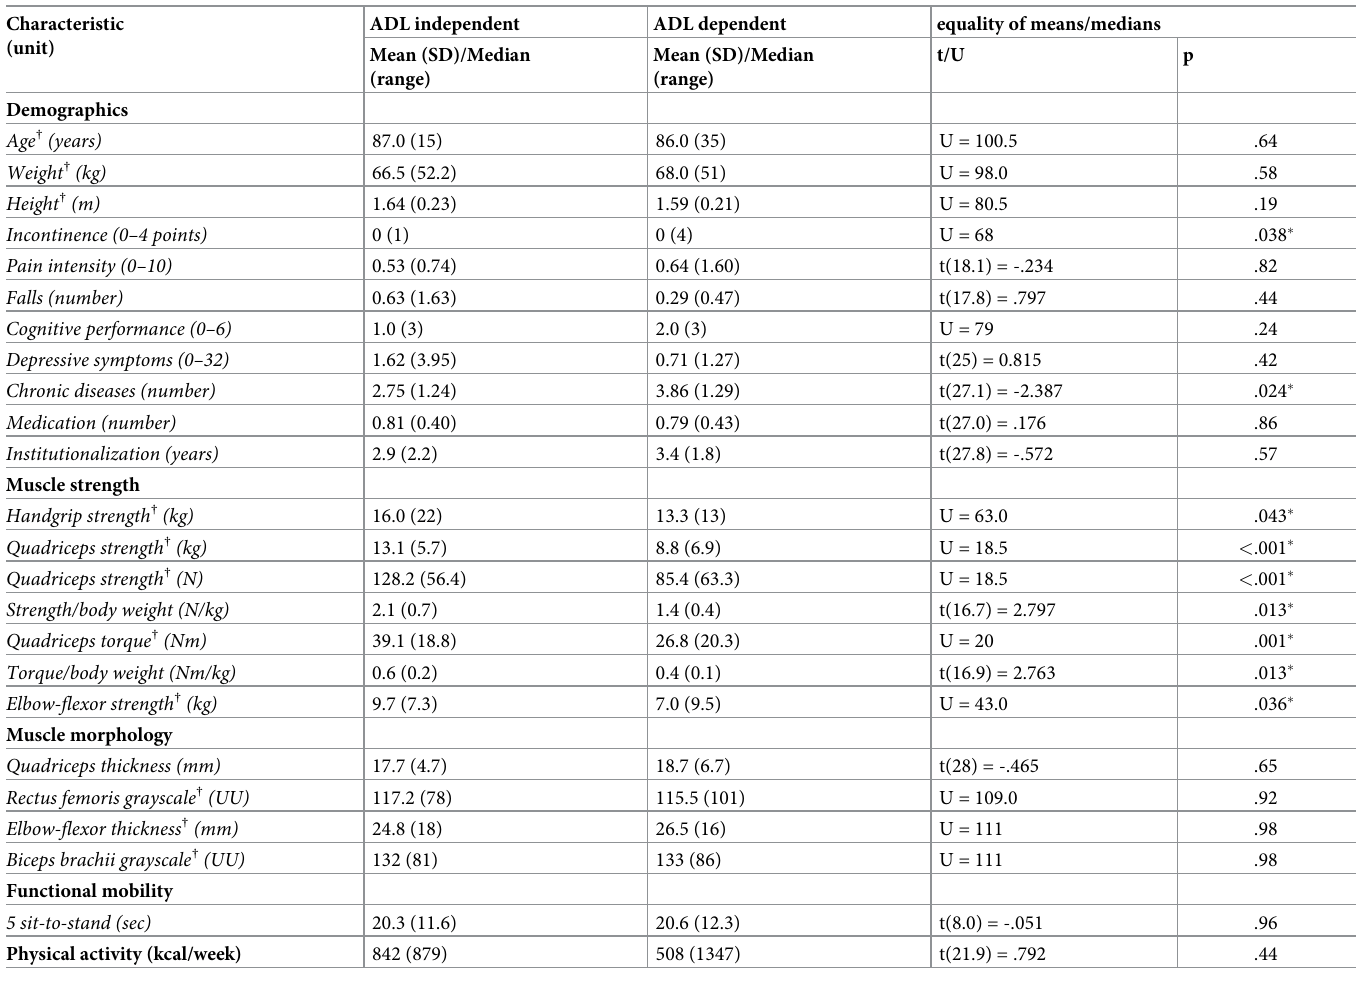
Table 2. Participants’ characteristics of the ADL dependent and independent